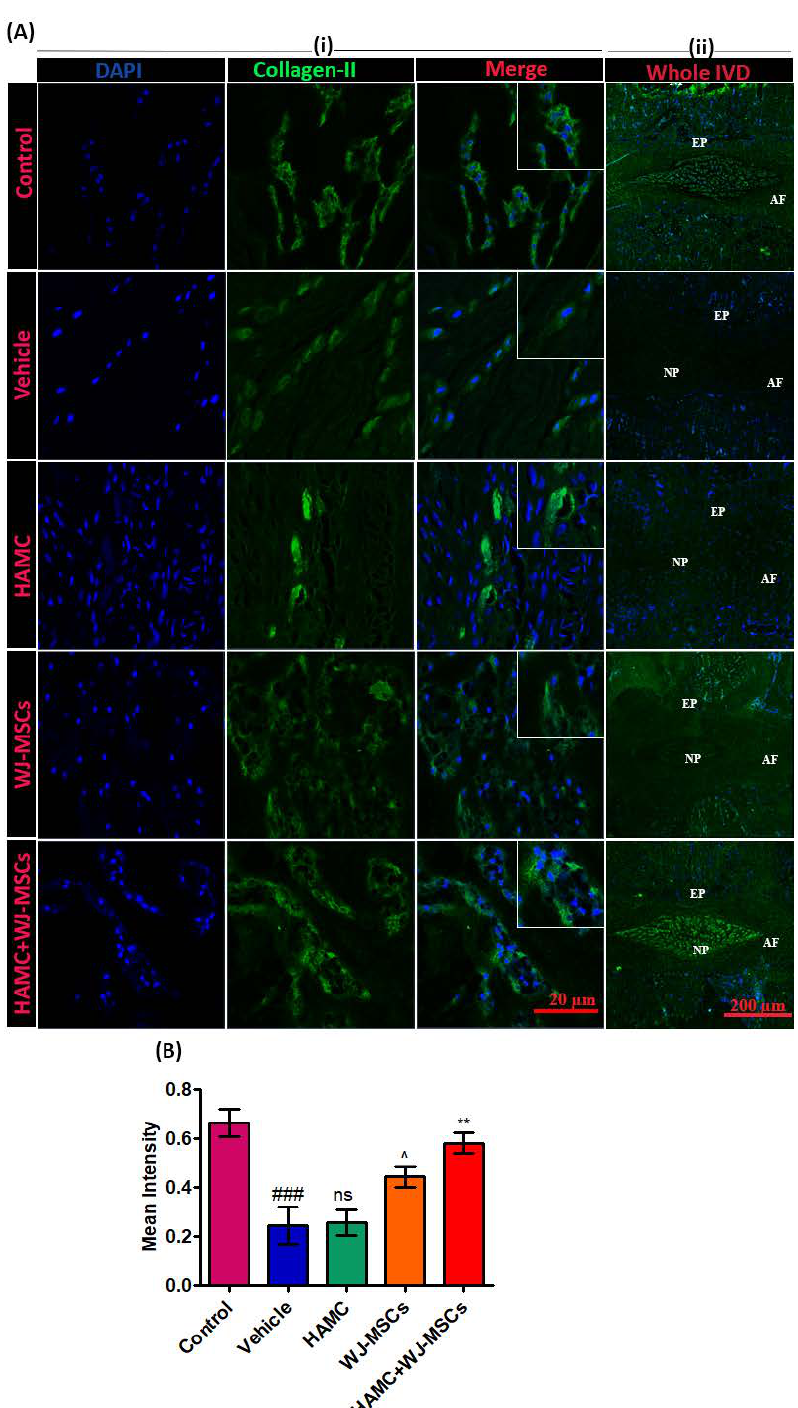
Figure 4. Combined injection of HAMC and WJ-MSC significantly restores collagen type II in degenerated disc. ( A ) Representative collagen II immunofluorescent staining. (i) Collagen expression at region of interest (ROI) and (ii) full power images demarcating entire disc (nucleus pulposus—NP, annulus fibrosus—AF and end plate—EP), and collagen II expression in whole NP area. ( B ) Quantitative immunofluorescence intensity for collagen II expression. Mean ± SEM, ( n = 3), one-way ANOVA followed by Tukey’s post-test. ### p < 0.001 (vehicle vs. control), ˆ p < 0.05 (WJ-MSCs vs. HAMC), ** p < 0.01 (HAMC + WJ-MSCs vs. WJ-MSCs), ns = non-significant. Combined injection of HAMC and WJ-MSCs significantly preserved the extracellular matrix (ECM) content, collagen type II compared to the vehicle, HAMC, or WJ-MSCs only injected